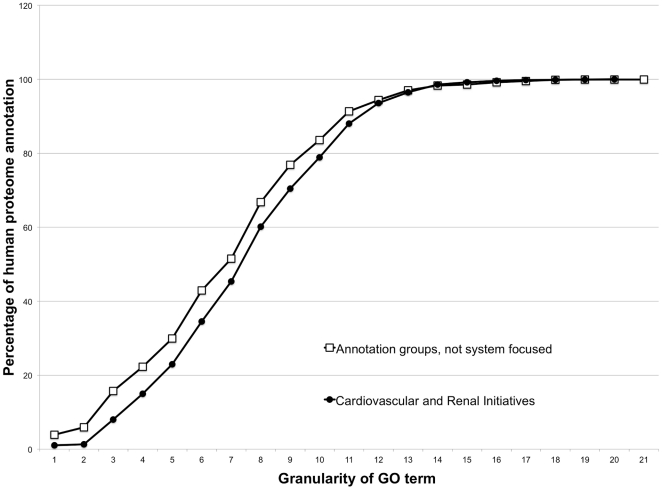
Distribution of GO term specificity by annotation source.Accumulative frequency of the distribution of GO terms applied in human annotations. Manual annotations created by the Cardiovascular and Renal Initiative, compared to those created by annotation groups without a system focused approach. Mann Whitney U confirms that the median granularity of GO terms used in human protein annotation by the Cardiovascular and Renal Initiatives is 8.0 (inter quartile range 6–10), compared to a median granularity of 7.0 (inter quartile range 5–9), for the GO terms used by other groups manually annotating to the human proteome (P<0.0001).